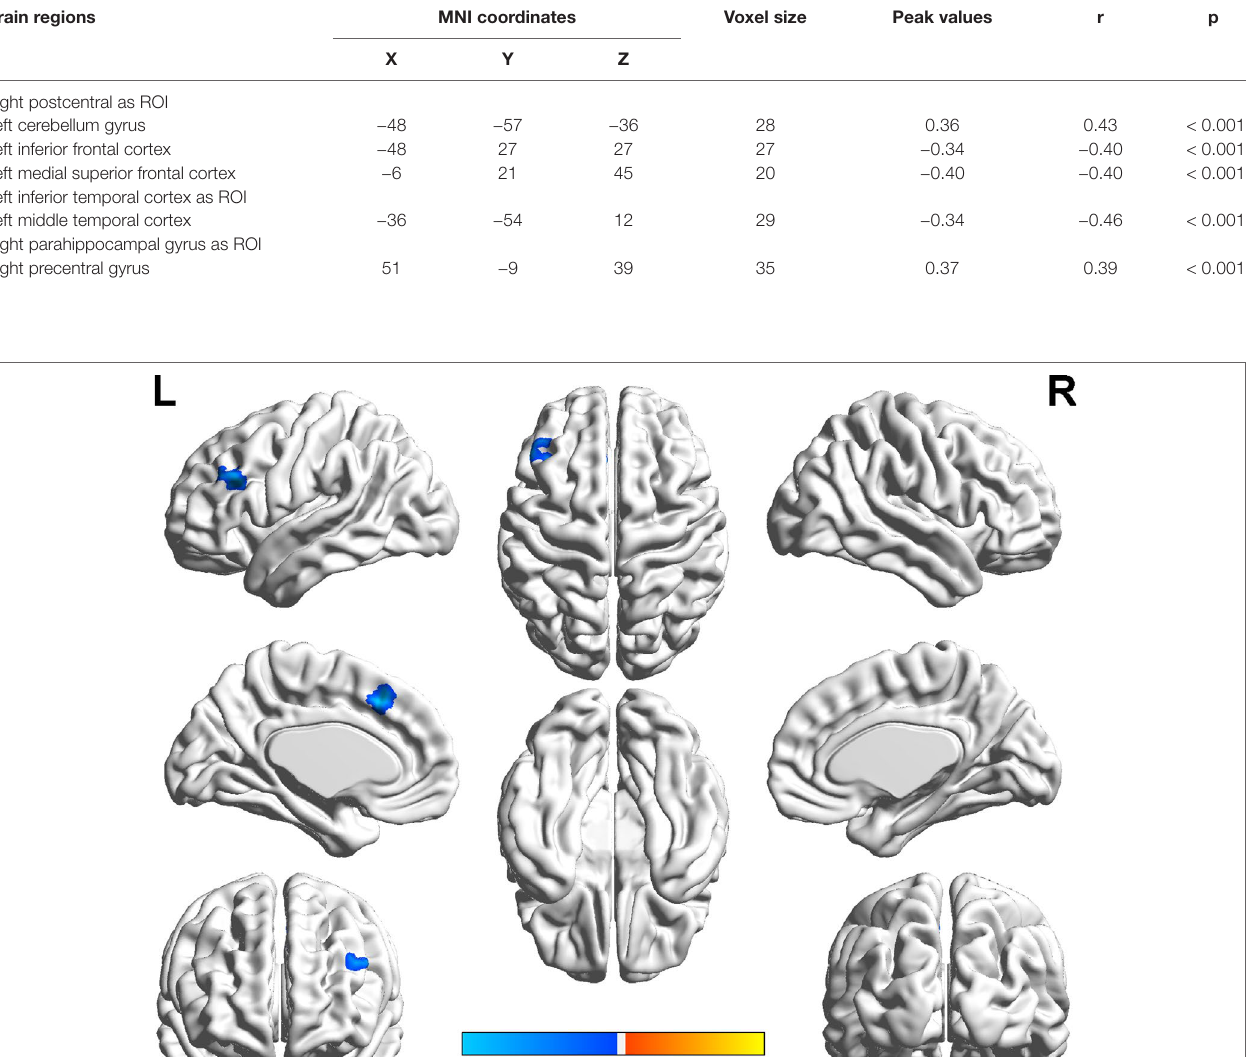
TABLE 2 | Brain regions with significant correlations between FC and state